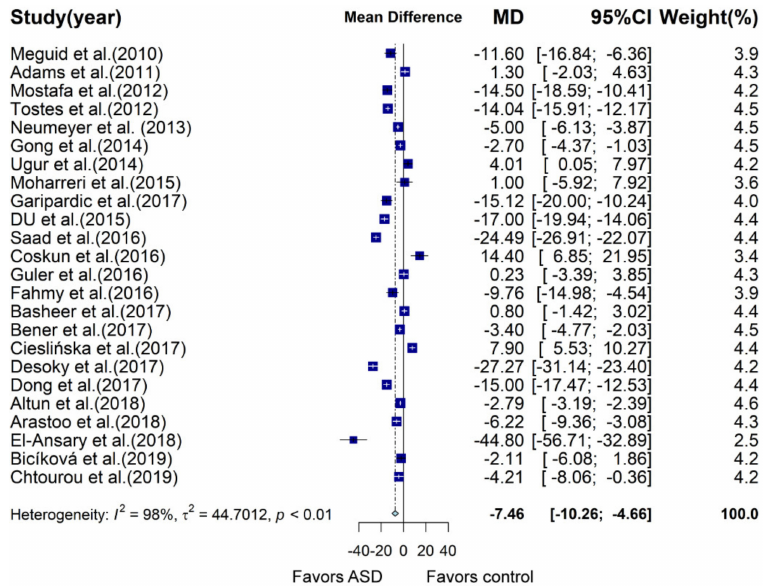
Figure 2. Forest plot of meta-analysis of 24 case control studies based on vitamin D concentration, showing that children and adolescents with autism spectrum disorder (ASD) have an average of 7.46 ng/mL lower vitamin D concentration than that of the controls, with 98% heterogeneity. MD, mean difference; CI, confidence interval.